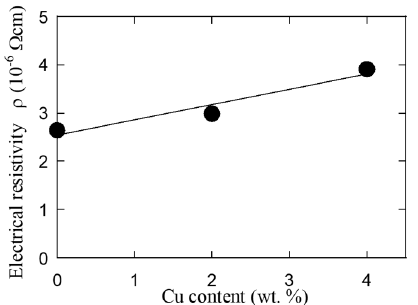
Figure 1. Electrical resistivity as a function of Cu content for unirradiated pure Al and Al-Cu alloys.